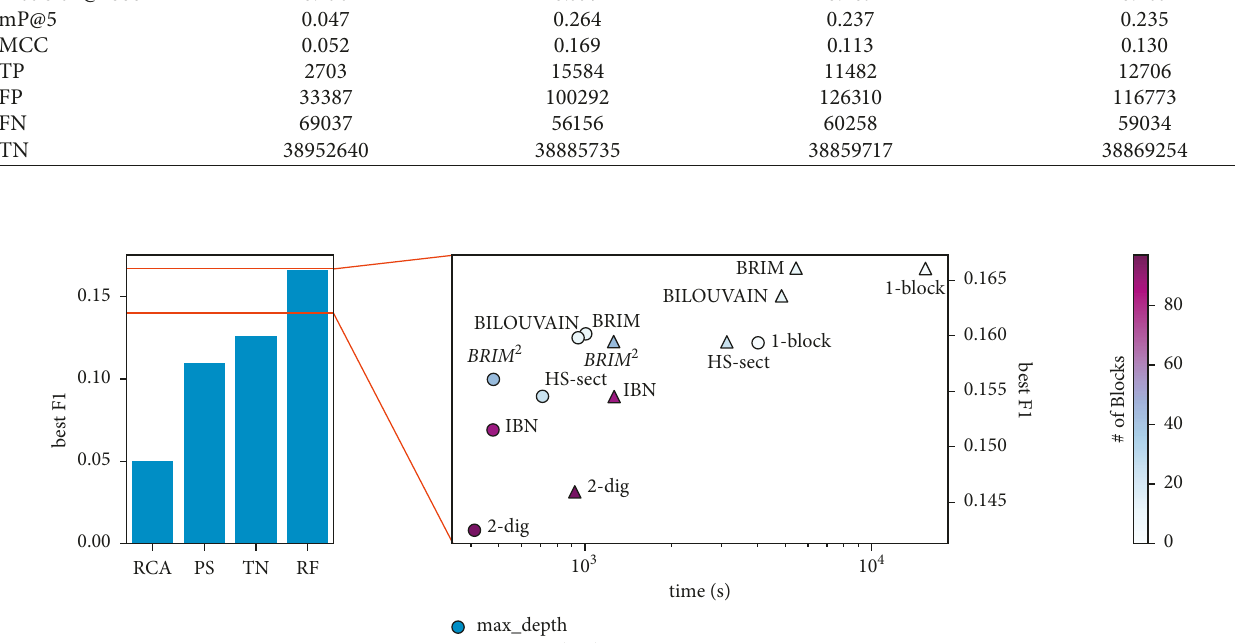
Figure 4: Performance of the random forest by varying the hyperparameters and the partitions that define the feature vector given as an input for each product. The results are optimized by tuning of max depth (circles) or min sample leaf (triangles). We also write the adopted partition and the color of the points represent the resulting number of blocks. On the horizontal axis, we report training time and on the vertical axis a performance indicator. Using more data (larger blocks for each product) provides better performance but takes longer time for training; smaller blocks lead to faster but less precise results. In any case, as evinced by the zoom given by the red lines on the plot on the left, random forest always outperforms the other models.